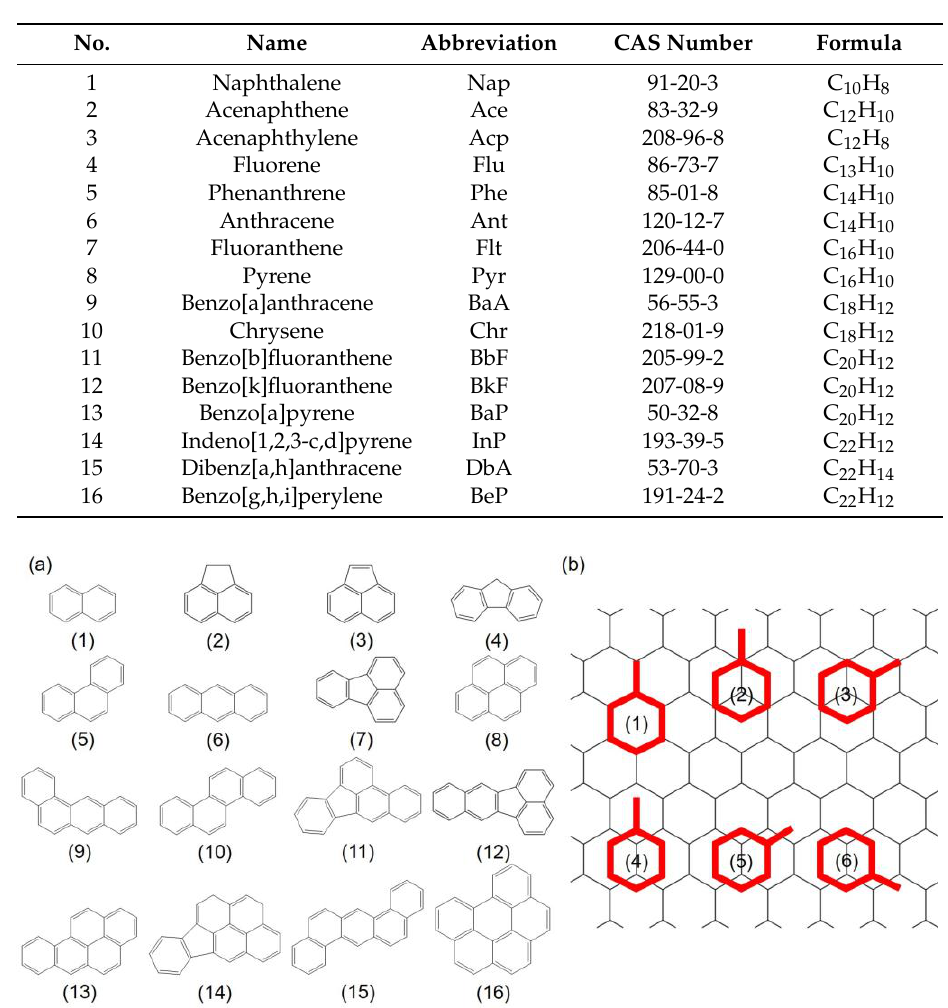
Table 1. Basic information of investigated polycyclic aromatic hydrocarbons (PAHs), including the name, abbreviation, CAS number and formula.